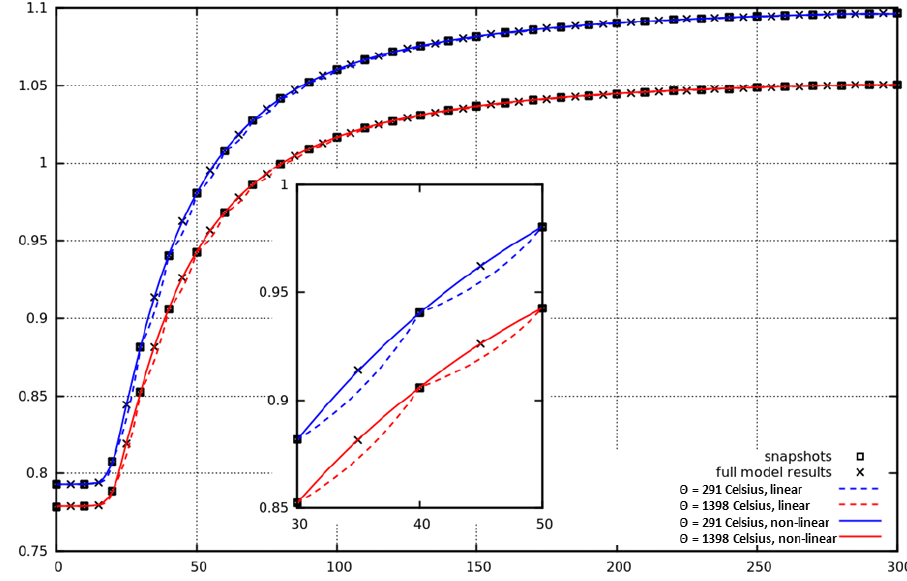
Figure 11. k eff against control-rod height. The dotted line corresponds to the reduced-order model results (LPOD) using the linear interpolation, and the solid line corresponds to the nonlinear interpo- lation. Two uniform temperature fields are used. For comparison, high-fidelity model results are shown, with the snapshots and midpoints (used in the nonlinear interpolation).